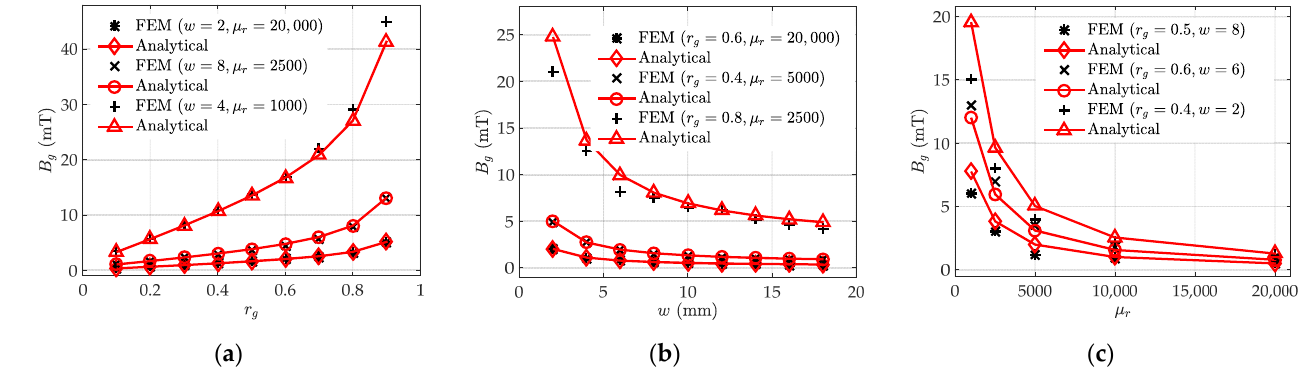
Figure 10. Comparison between the FEM simulation (black markers) and analytical (red curves) leakage magnetic flux density B g with the change of ( a ) air gap ratio r g ; ( b ) air gap thickness w ; ( c ) relative permeability µ r .